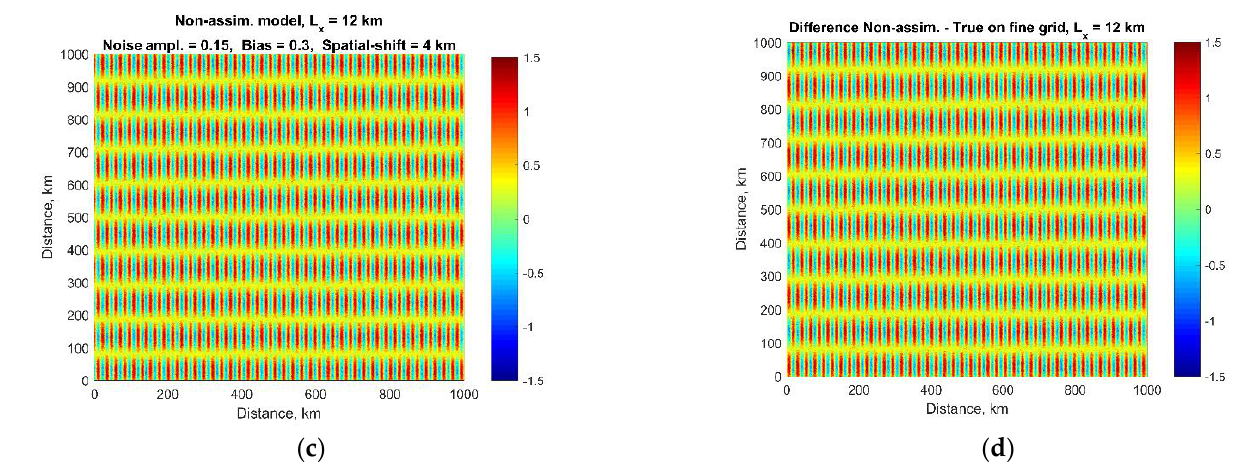
Figure 9. Maps of the field variable before data assimilation for multiple eddy case with 𝐿 𝑥 = 12 km: ( a ) true field on fine grid, ( b ) true field on parent grid, ( c ) non-assimilated model, ( d ) difference between non-assimilated model and true field.